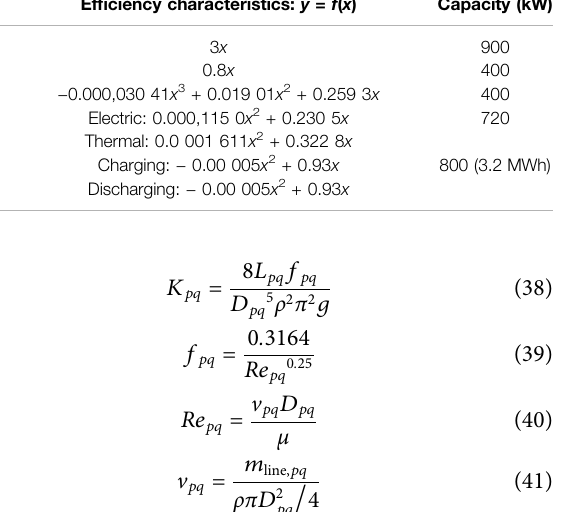
TABLE 1 | Parameters for devices in Figure 1 .